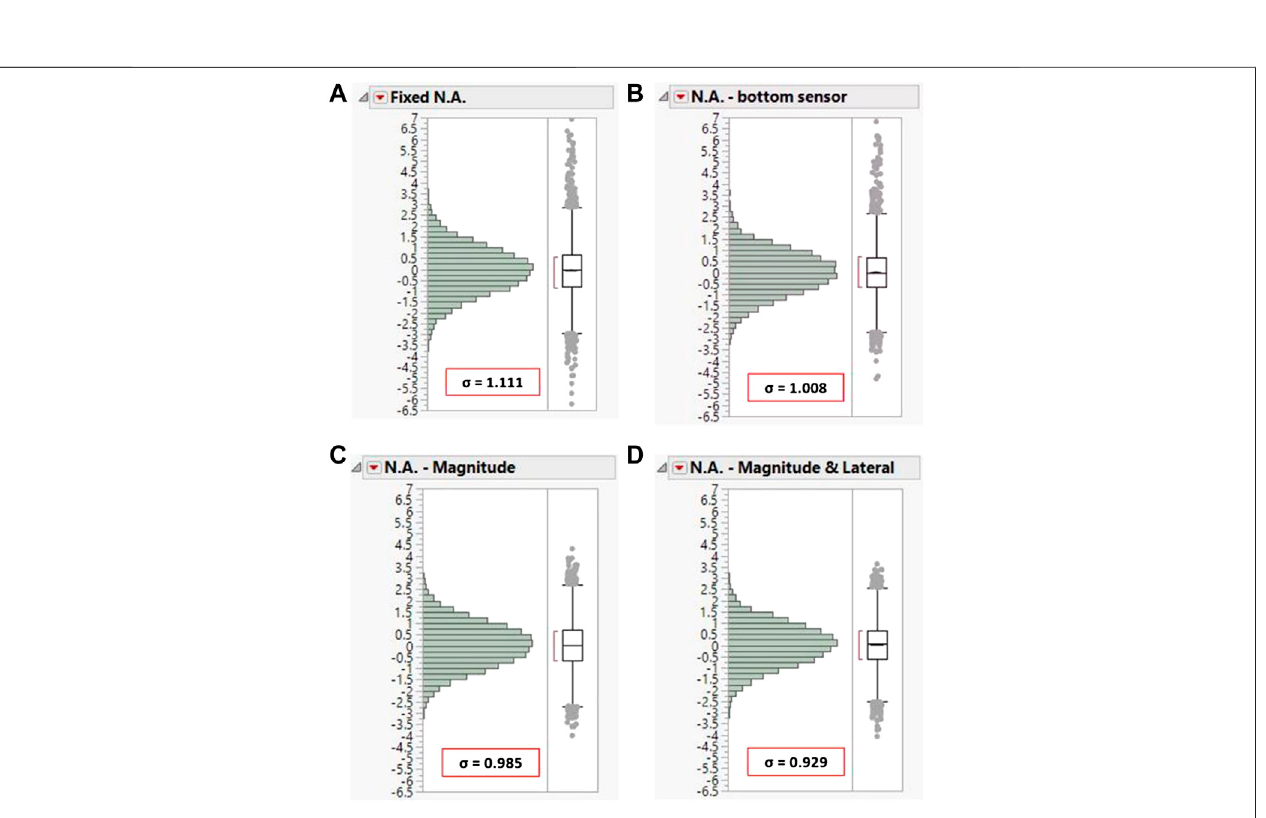
Frontiers in Built Environment |